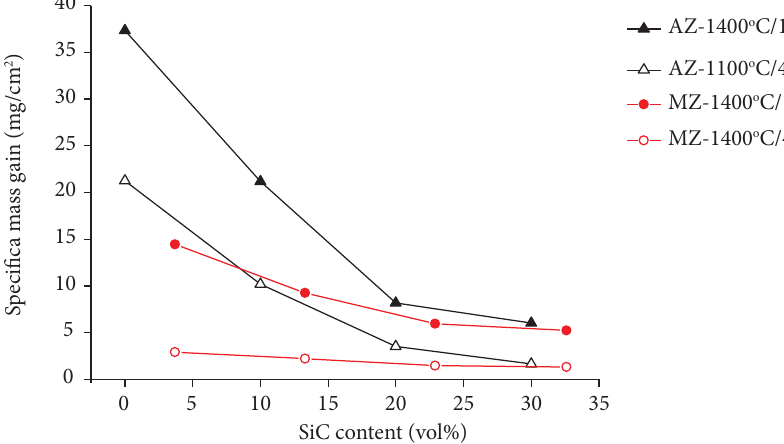
-SiC composites as function of SiC content after oxidation at 1100 °C/4h and at Figure 9. Specific mass gain of ZrB 2 1400 °C/1h. Composites processed with different ZrB